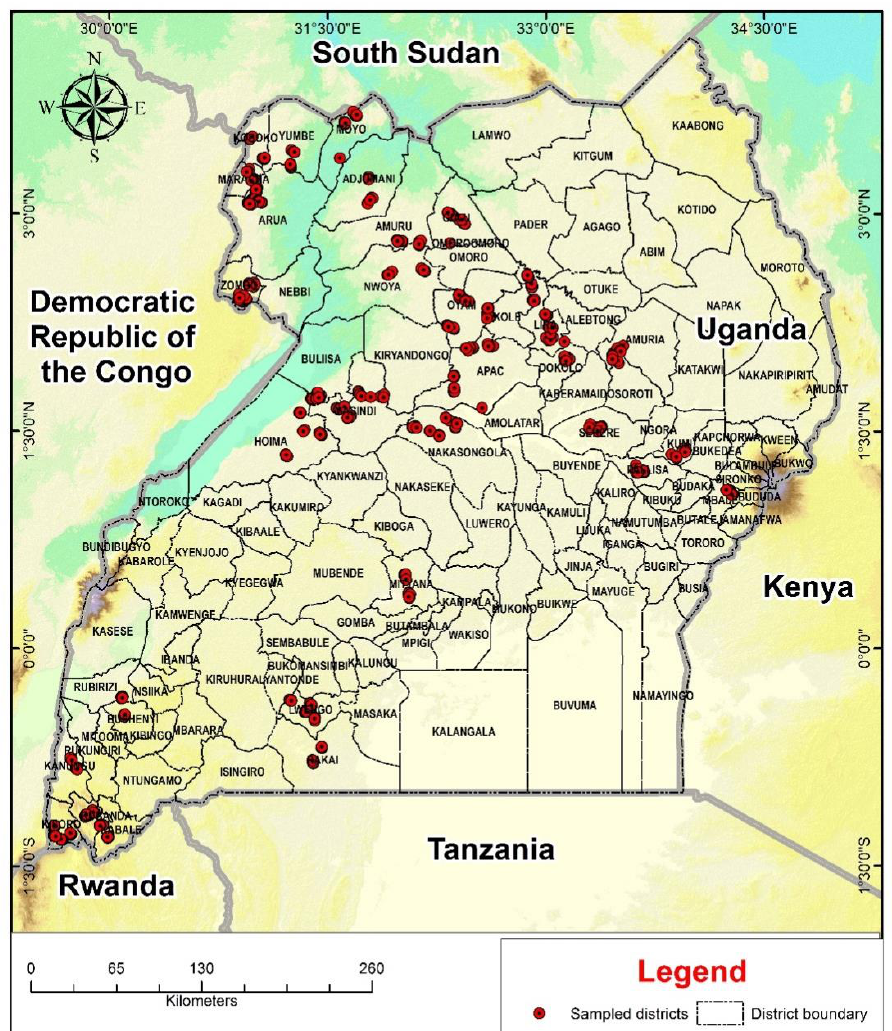
Figure 2. Map of Uganda showing the districts sampled during the study.